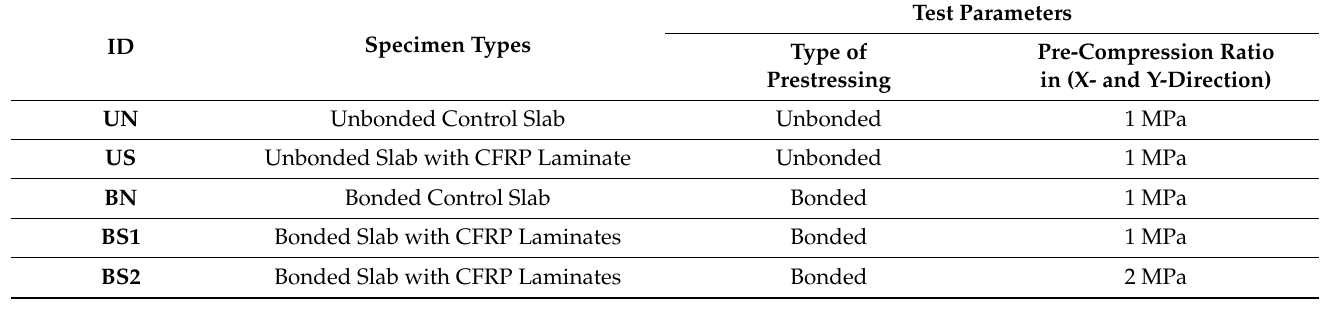
Table 1. Summary of specimen’s type.